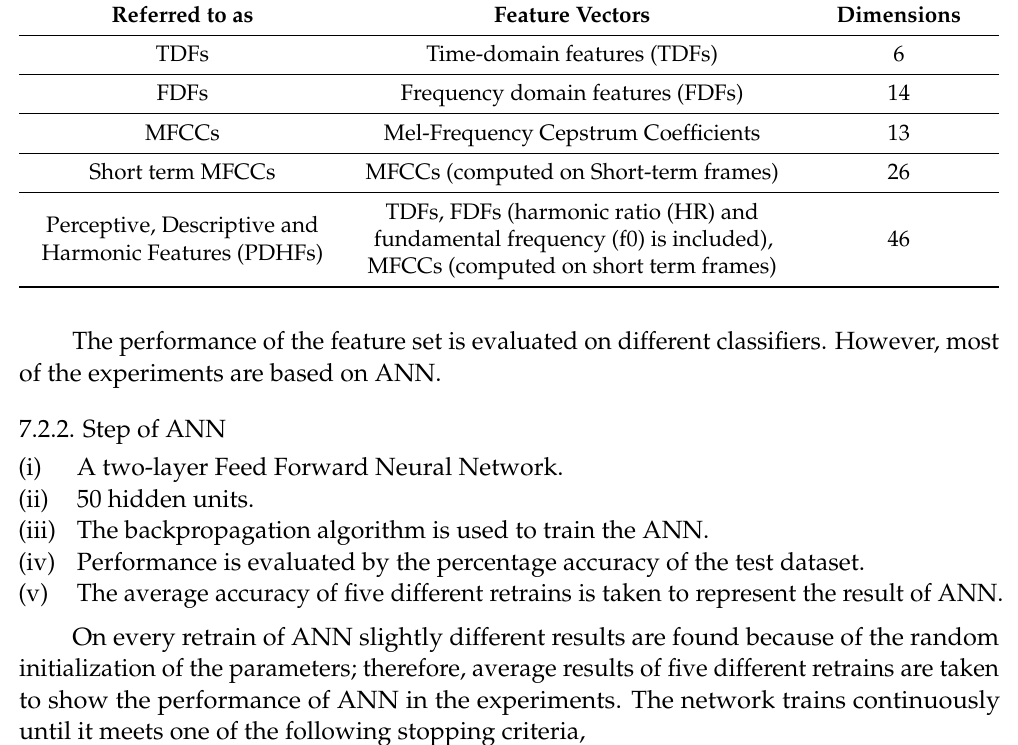
Table 4. Dimensions of feature sets used in the experiments. Referred to as Feature Vectors Dimensions TDFs Time-domain features (TDFs) 6 FDFs Frequency domain features (FDFs) 14 MFCCs Mel-Frequency Cepstrum Coefficients 13 Short term MFCCs MFCCs (computed on Short-term frames) 26 TDFs, FDFs (harmonic ratio (HR) and Perceptive, Descriptive and Harmonic Features (PDHFs)